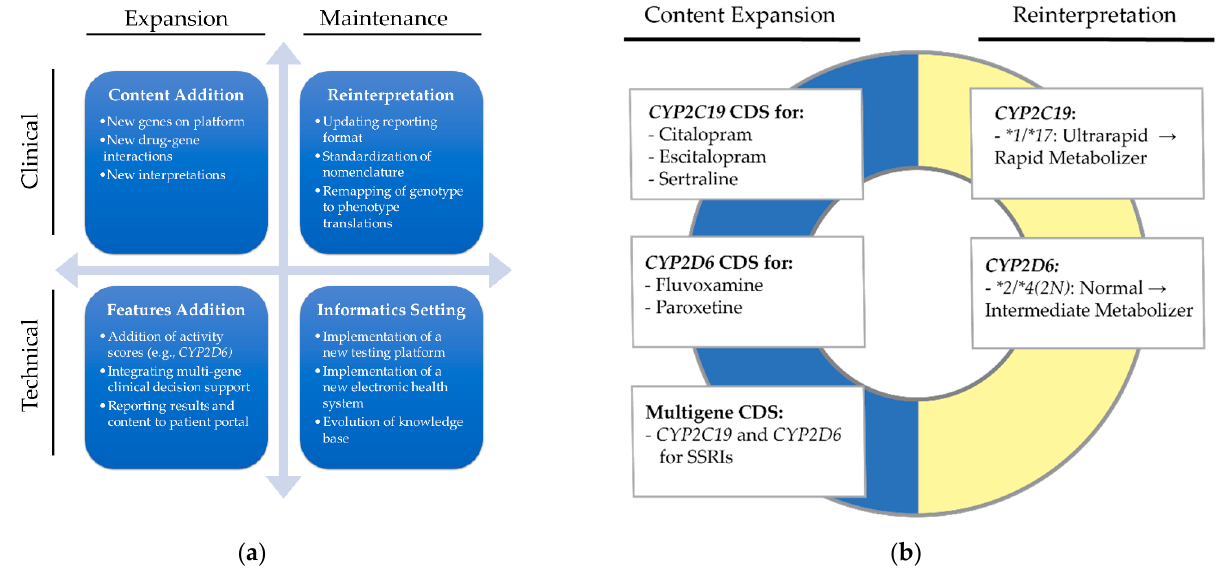
Figure 1. Potential utility of reprocessing pharmacogenomics results. ( a ) Different types of reprocessing utility; ( b ) specific use cases of reprocessing to support clinical maintenance and SSRI content expansion (example historic results and reinterpreted phenotypes are listed).